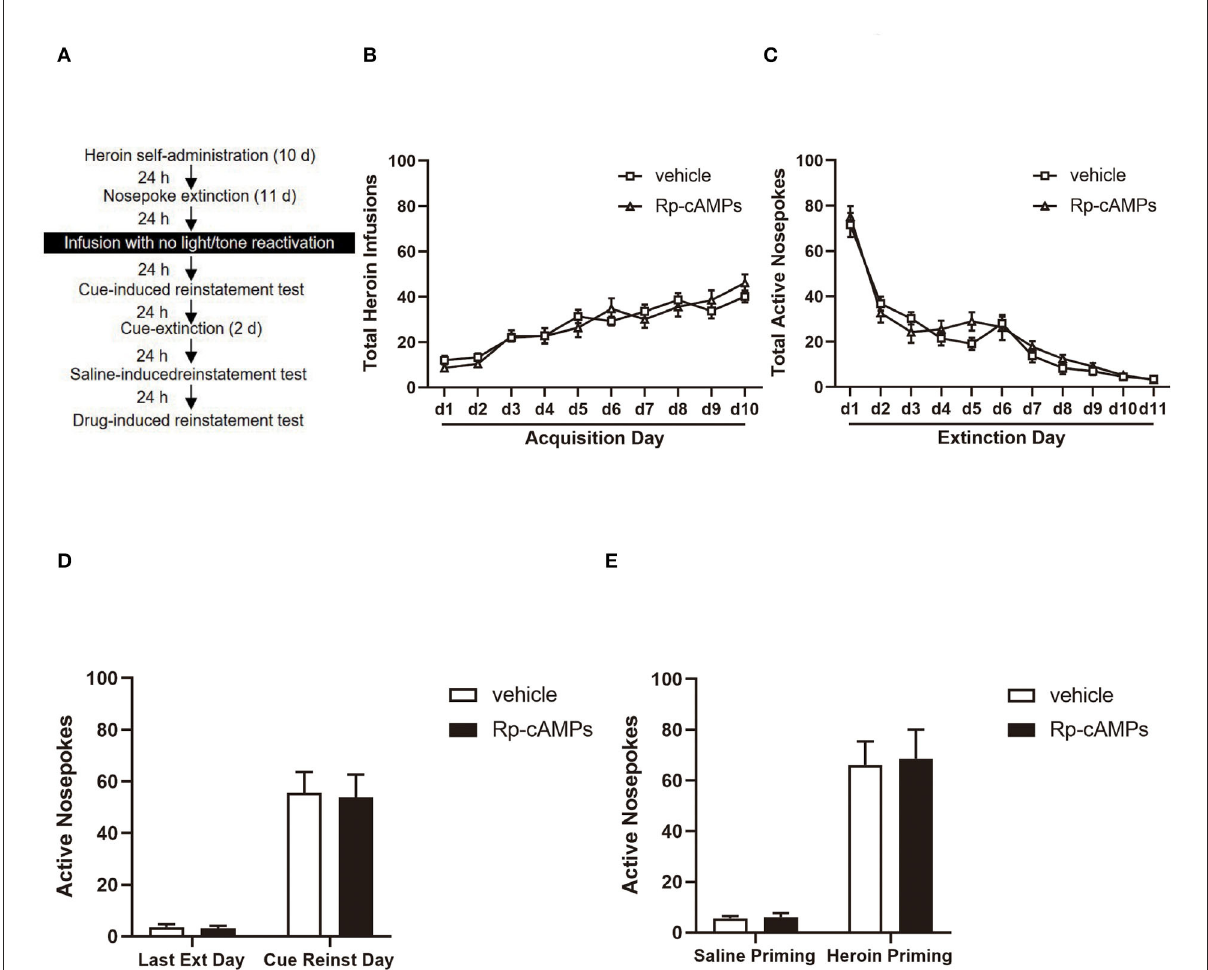
FIGURE3 The effect of intra-BLA PKA inhibition without reactivation on the subsequent cue- and heroin-induced reinstatement tests. (A) Timeline of the experimental procedure. (B) The total number of infusions during the acquisition of heroin self-administration. (C) The total number of active nosepoke responses during extinction sessions. (D) Active nosepoke responses during the last day of extinction and the cue-induced reinstatement test. (E) Active nosepoke responses during the saline- or heroin-primed reinstatement tests. The value of n = 8 rats per group. Data are means ± SEM. Ext, extinction; Reinst,